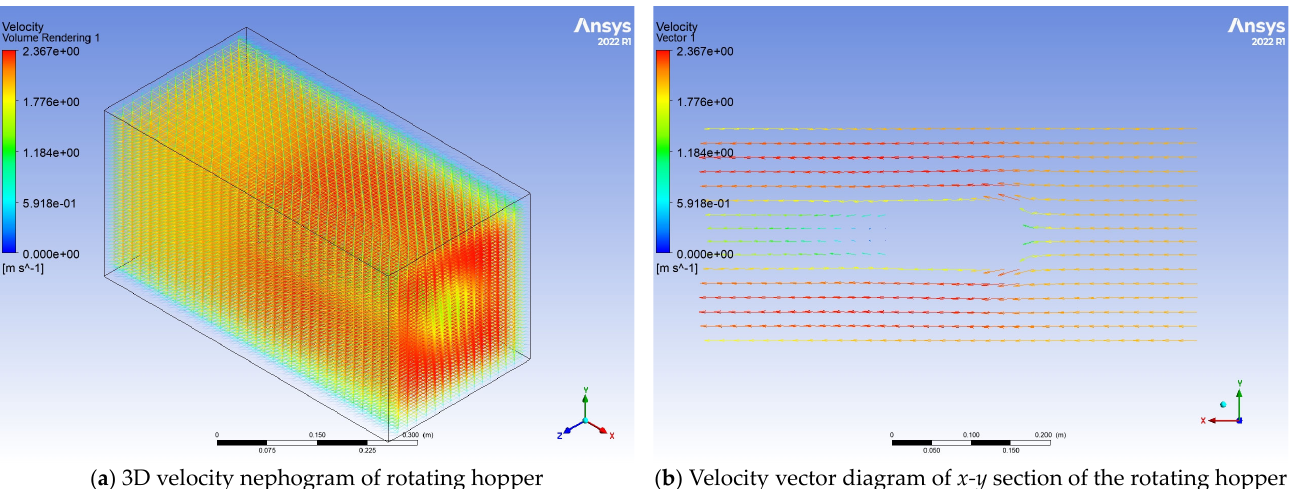
Figure 19. Three ‐ dimensional velocity nephogram of r = 0, v = 2 freezer and x ‐ y plane velocity vector Figure 19. Three-dimensional velocity nephogram of r = 0, v = 2 freezer and x-y plane velocity vector diagram of freezer. diagram of